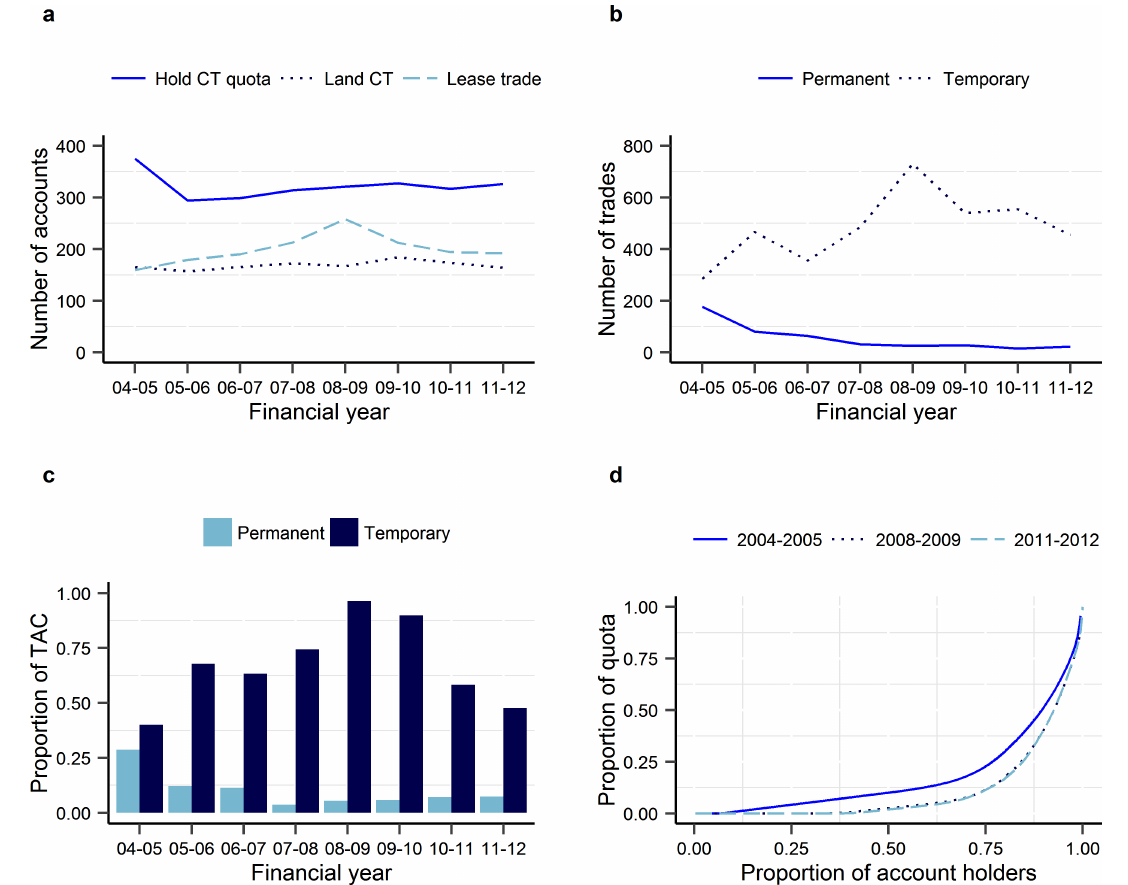
Fig. 3 . Trends in key descriptors of the coral trout (CT) quota lease market, 2004-2005 to 2011-2012: (a) number of accounts holding CT quota, landing CT, and involved in leasing, (b) number of trades, (c) quantity of quota traded as a percentage of the total allowable catch (TAC), (d) cumulative proportion of quota ownership vs cumulative proportion of account holders in which movement toward the bottom right corner indicates an increase in quota